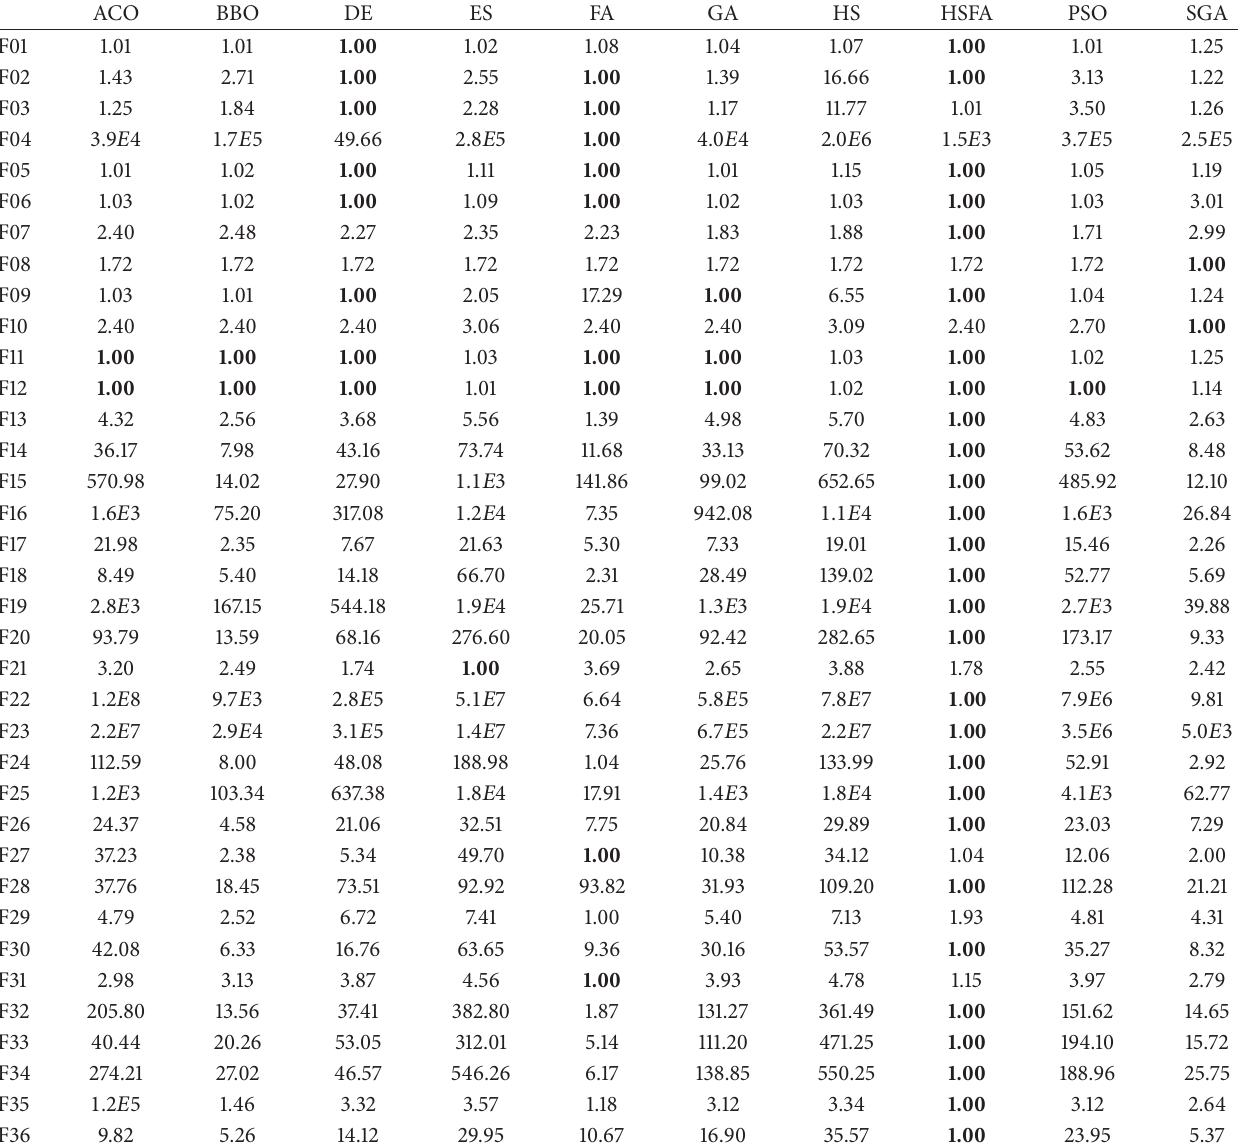
Table 2: Mean normalized optimization